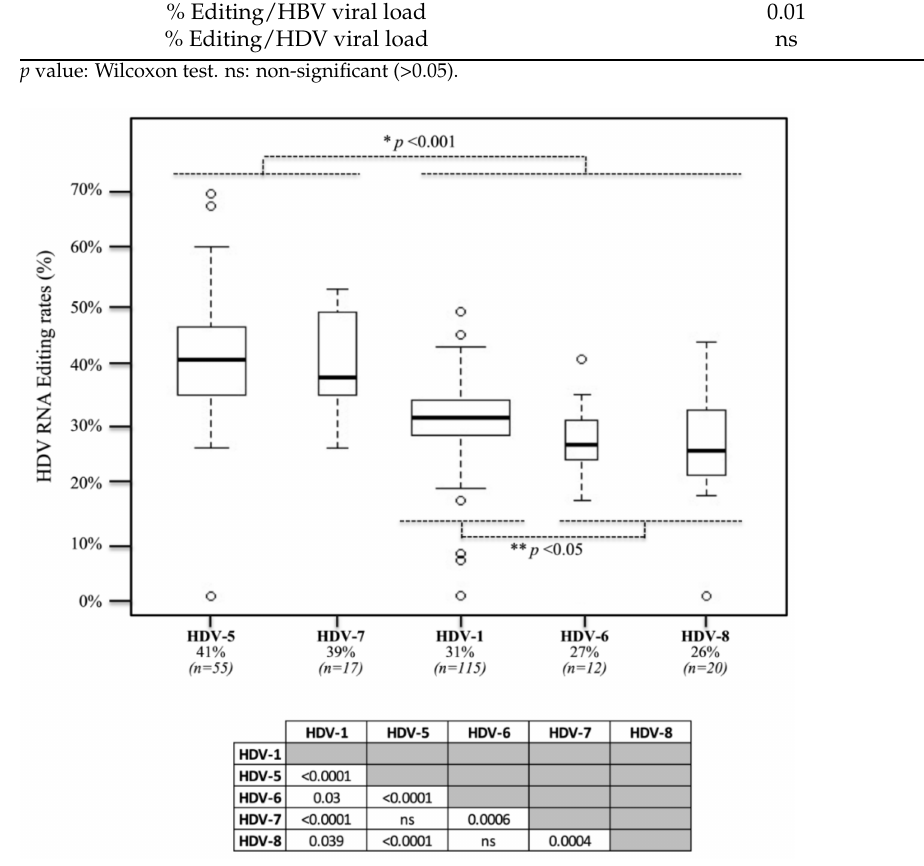
Figure 2. Plasma HDV RNA editing rates according to the HDV genotype. Two-hundred and nineteen samples from untreated infected patients were analyzed. The box plots, generated with ggplot2 application, show the median editing rate and the value distribution obtained with different genotypes. Significantly higher editing rates (expressed in percentage) were observed for HDV-5 and HDV-7 strains, compared to HDV-1 (African and non-African genotypes), HDV-6 and HDV-8 (* p < 0.001). In addition, HDV-6 and HDV-8 editing rates were significantly lower than HDV-1 ones (** p < 0.05). Comparison of editing rates was performed by means of Kruskal–Wallis, chi-square, and Wilcoxon’s